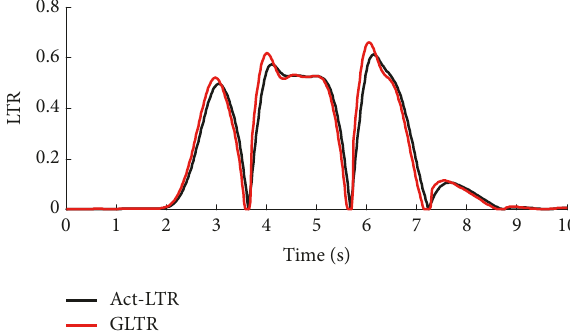
Figure 10: Prediction result for 85-km/h DLC using the grey LTR